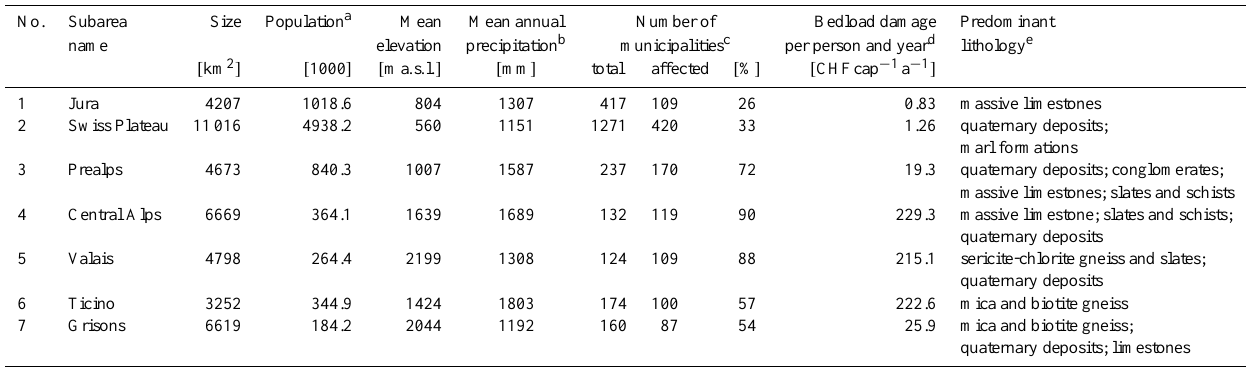
Table 1. Characteristics of the seven Swiss subareas applied in this contribution (cf. Fig. 1).